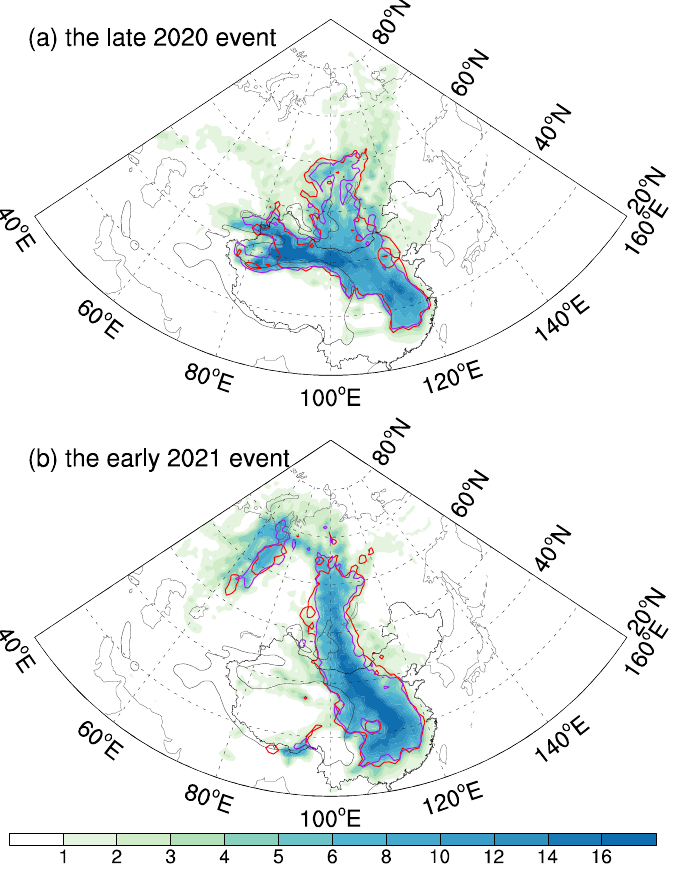
Figure 2. Averaged trajectory density (number of trajectory points associated with each grid point) during the 7 days prior to the final day of the late 2020 event and the early 2021 event starting at 50 hPa. The red and purple lines represent the 5 density contours starting at 10 and 30 hPa, respectively. The black contours indicate the 2000 m terrain height.